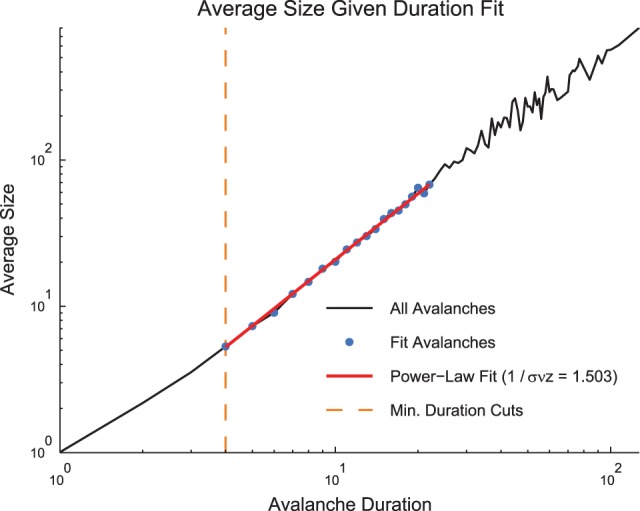
Size given duration fit. The average avalanche size as a function of avalanche duration follows a power law with a positive slope. Because these data are not a probability distribution, an MLE approach to fitting was not possible. We used a weight least squares fitting of the logarithmically scaled durations and average sizes. We also preserved minimum duration and occurrence cuts from the MLE fitting approach for size and duration distributions. Note, using the average size given duration fit, we found 1∕σνz = 1.503. Using the shape collapse analysis, we found 1∕σνz = 1.498 (Figure 6E). This represents a difference of 0.3%. The data for this figure was taken from the cortical branching model.